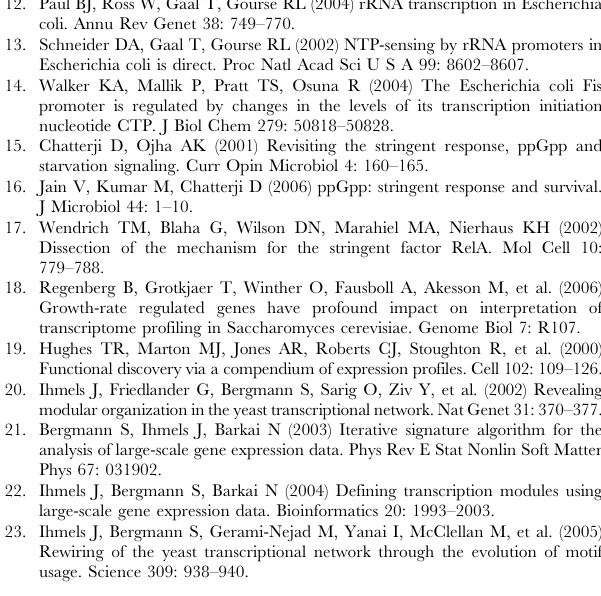
Table S2 Correlations between growth and the modules average